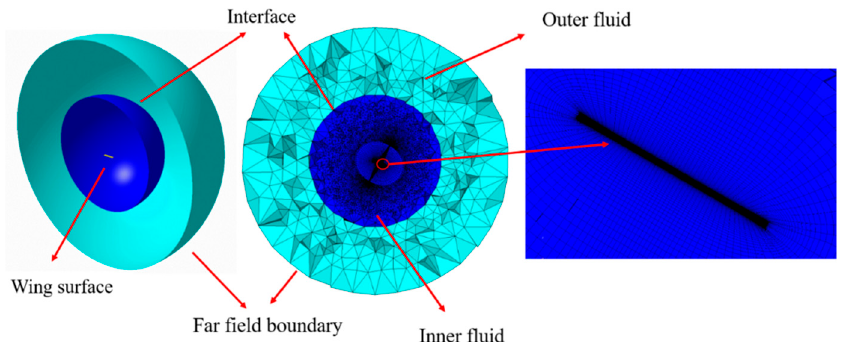
Figure 7. Mesh used in the CFD calculation.